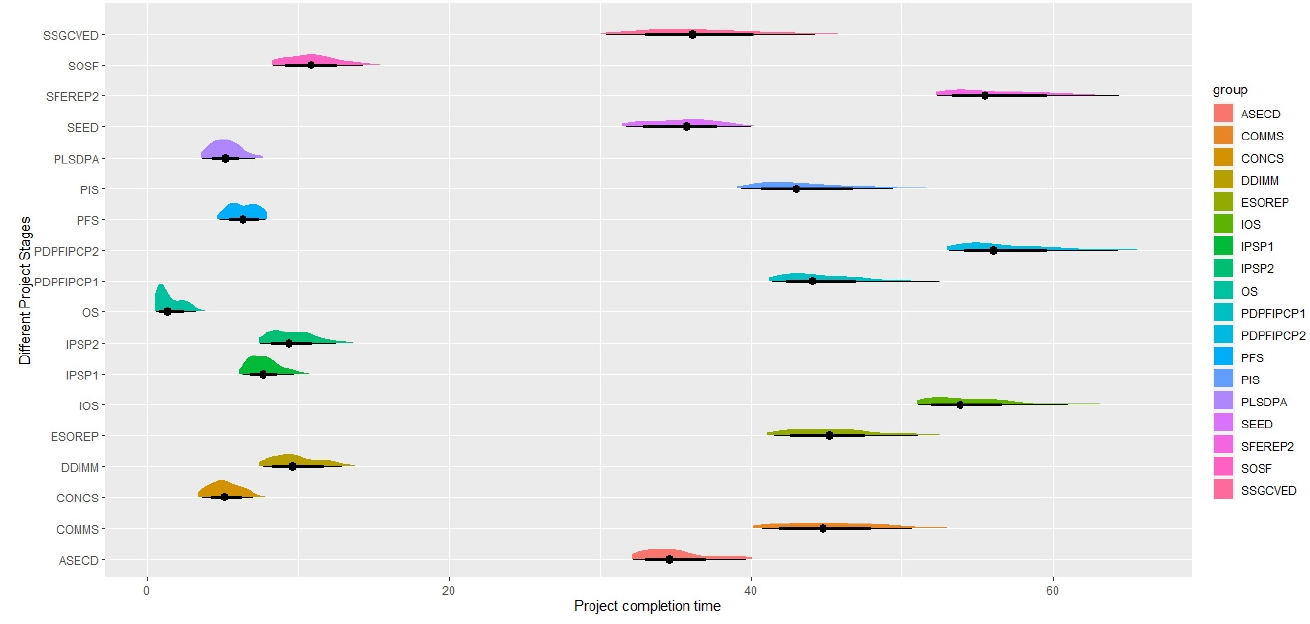
Figure 8. Deviations in time schedules for the project implementation stage (PIS).